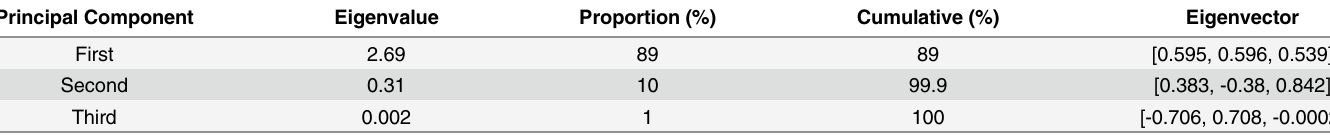
Table 9. Eigenvalues and Eigenvectors obtained through PCA processing of the normalized S/N ratios. Principal Component